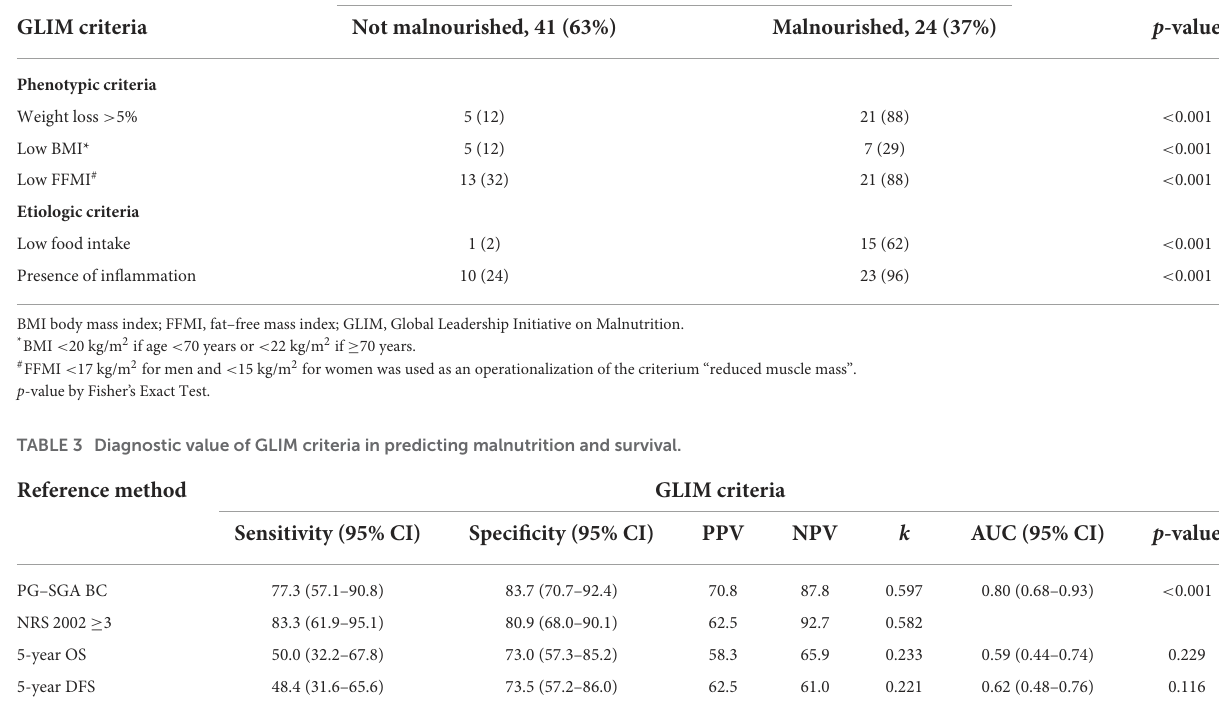
TABLE 2 The prevalence of the phenotypic and etiologic GLIM criteria according to malnutrition diagnosis.